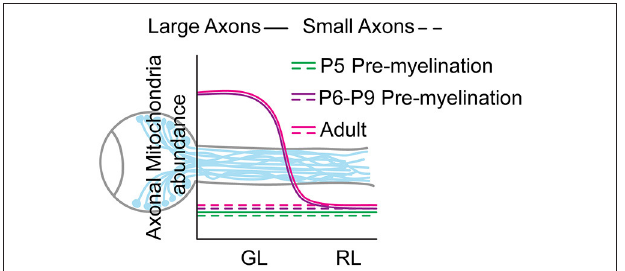
FIGURE 4 | Model of the mitochondrial distribution in RGC axons of the optic nerve GL and RL